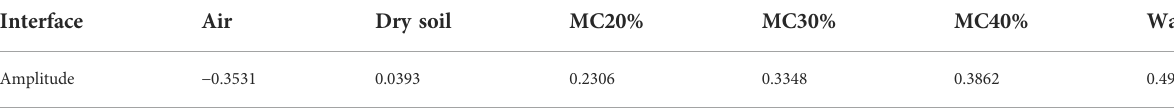
TABLE 2 Relative amplitude of the interface re fl ection (the relative wave amplitude at the masonry-metal interface is 1). Interface